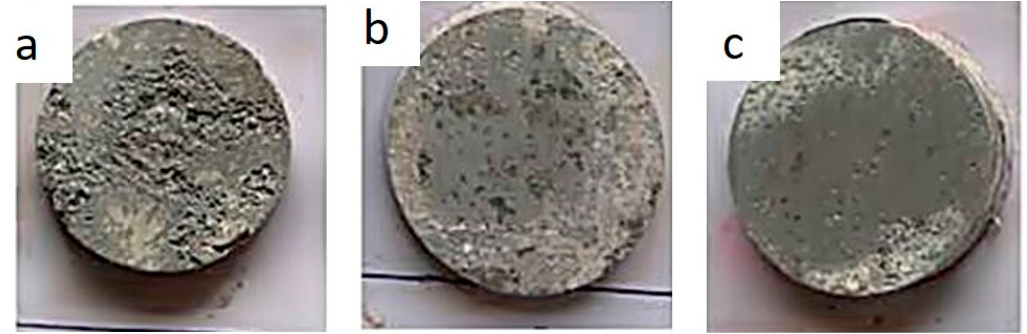
Figure 13. Surface macro-morphology images after salt spray test in 3.5% NaCl solution: ( a ) Acrylic paint ED coat; ( b ) 2-coat polyester without primer; ( c ) 3-coat polyester with epoxy primer. Table 5. Corrosion rate of samples after 24, 48, 72, and 96 h of salt spray test. Experimental Sample